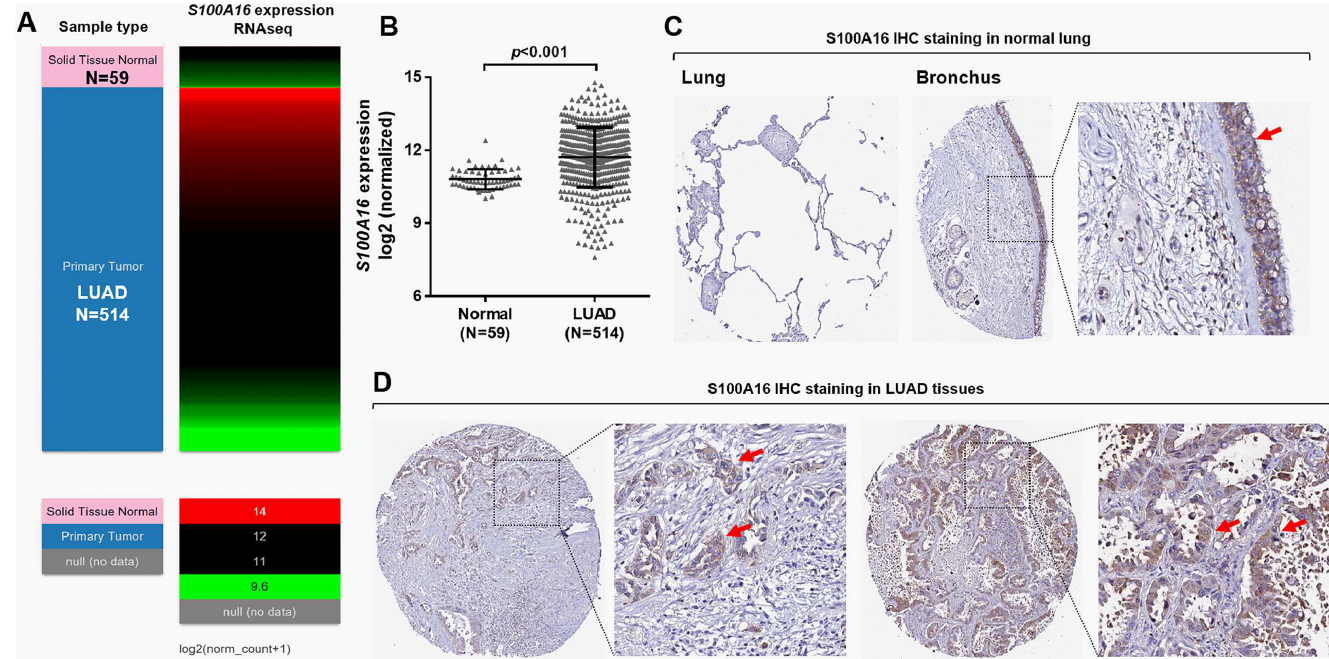
Fig 1. LUAD tissues had significantly elevated S100A16 expression compared with normal lung tissues. A-B. Heatmap (A) and plots chart (B) showing S100A16 RNA expression in LUAD tissues (N = 514) and in normal lung tissues (N = 59). C-D. S100A16 IHC staining images. C: Normal lung (left) and bronchus (right). D: LUAD tissues. Image credit: Human Protein Atlas. Images were obtained from: v18.proteinatlas.org, via: http://www.proteinatlas.org/ENSG00000188643-S100A16/ tissue/lung#img http://www.proteinatlas.org/ENSG00000188643-S100A16/tissue/bronchus#img http://www.proteinatlas.org/ENSG00000188643-S100A16/pathology/ tissue/lung+cancer#img.